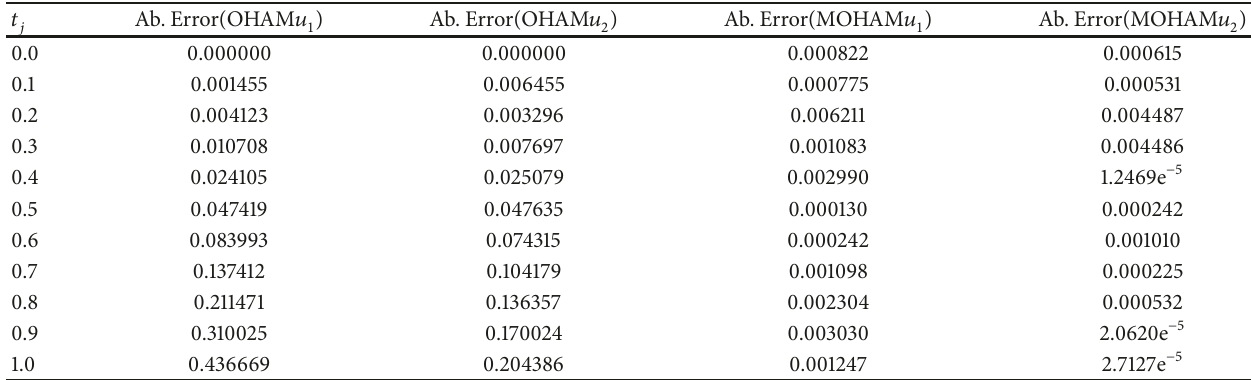
Table 3: Absolute errors of applying OHAM and MOHAM for Example 1.